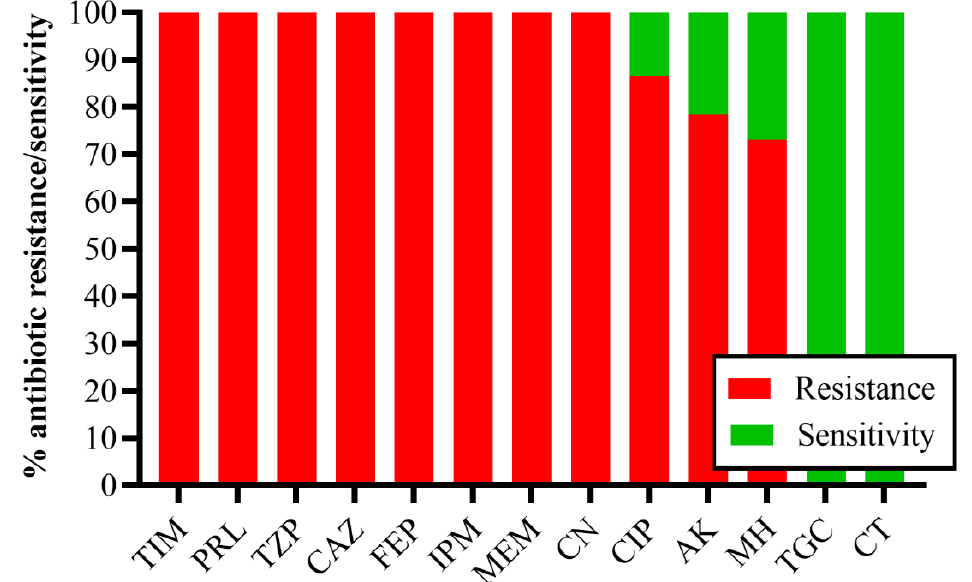
Figure 1. Antibiotic resistance profile of CRACB isolates. The different classes of antibiotics are TIM: